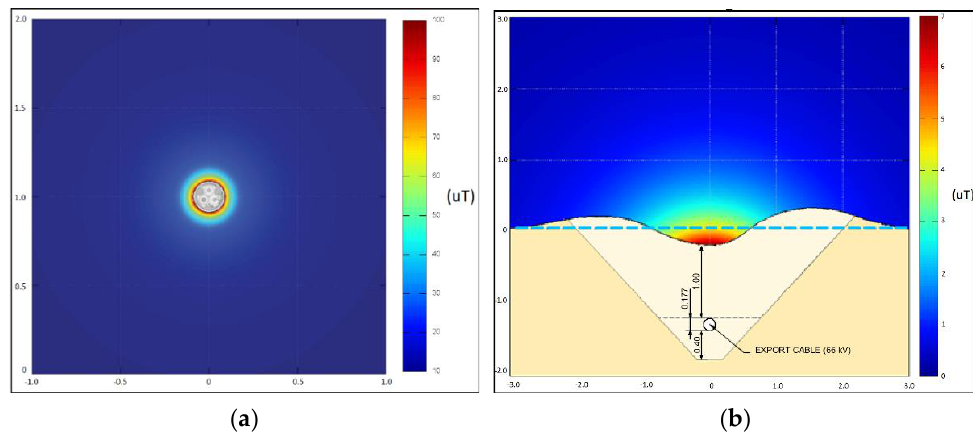
Figure 6. EMC modeling for the inter-array ( a ) and export ( b ) cables.